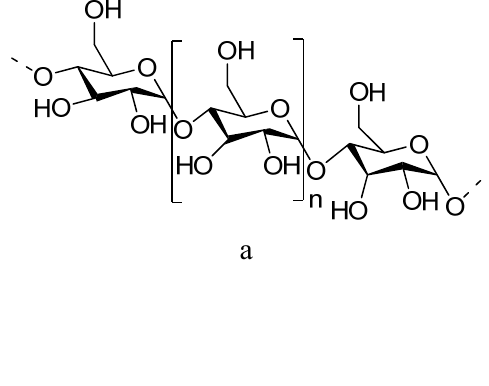
Figure 9. Chemical structure of starch, with a) amylose and b)